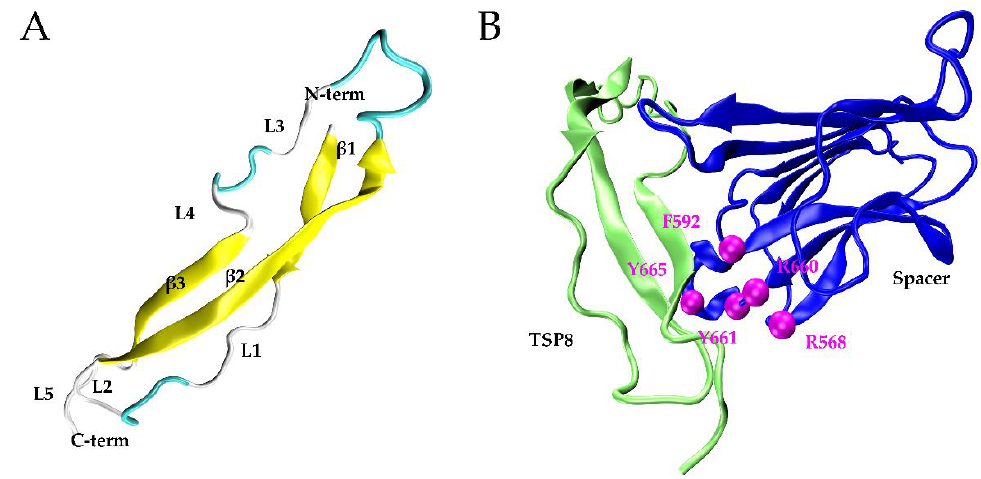
Figure 1. The models of the TSP8 domain and the TSP8-Spacer complex. ( A ) The best model of TSP8 domain from the Phyre2, including three β -strands (yellow), three β -turns (cyan), and five loops (grey); ( B ) conformation of the TSP8 domain (left, green) interacting with the Spacer domain (right, blue) (PDB ID: 3GHM) in Model A. Exosite-3 (magenta) of the Spacer domain was illustrated. Table 1. Residue interactions on the static interface of Model A and B. Model